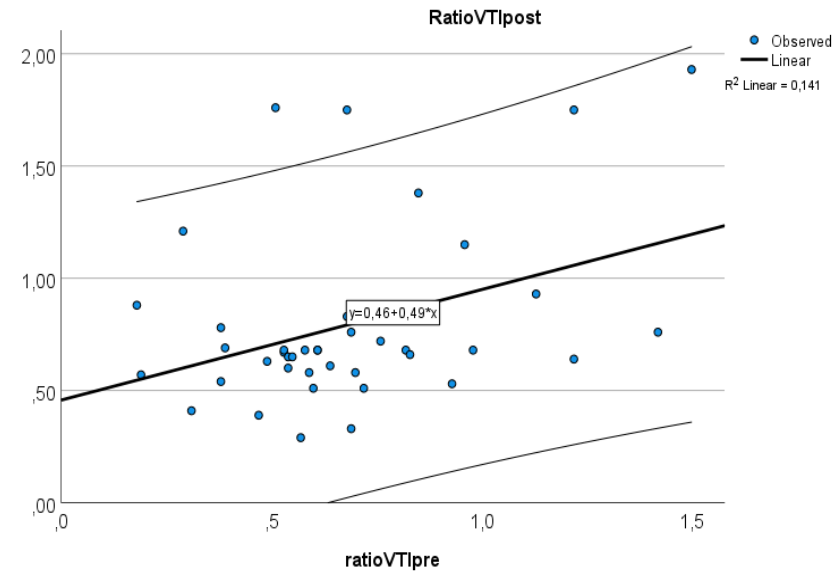
Figure 5. Relationship between preoperative and postoperative VTI ratios. Table 1. Demographic and clinical parameters (operation time and risk factors).